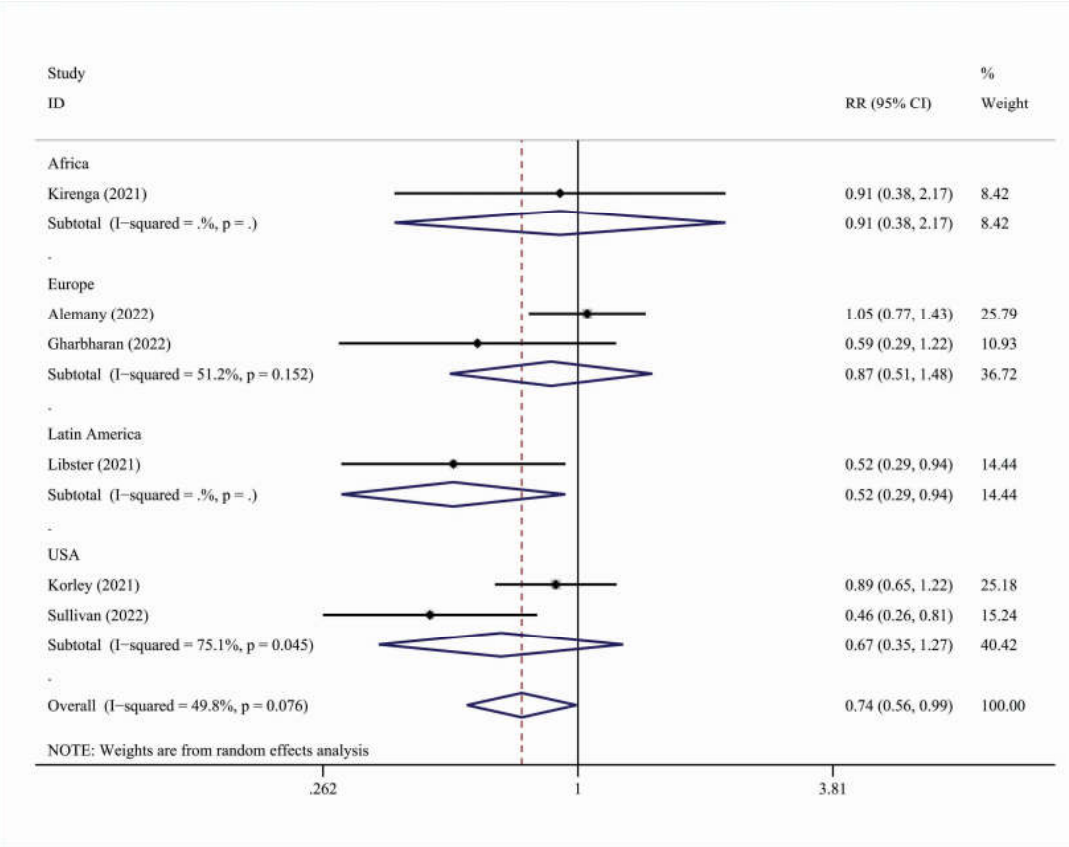
Figure 4. Forest plot describing the association between convalescent plasma treatment and 28-day hospitalization outcomes. Apart from the overall analysis, the subanalysis on geographic region is presented . Table 7. Subanalysis on hospitalization (28-day).